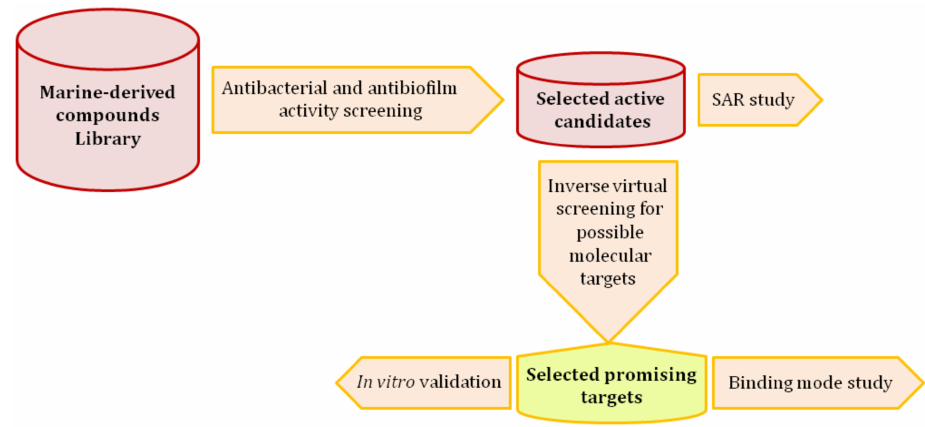
Figure 2. Outline of the procedure used in this study. SAR: structure–activity